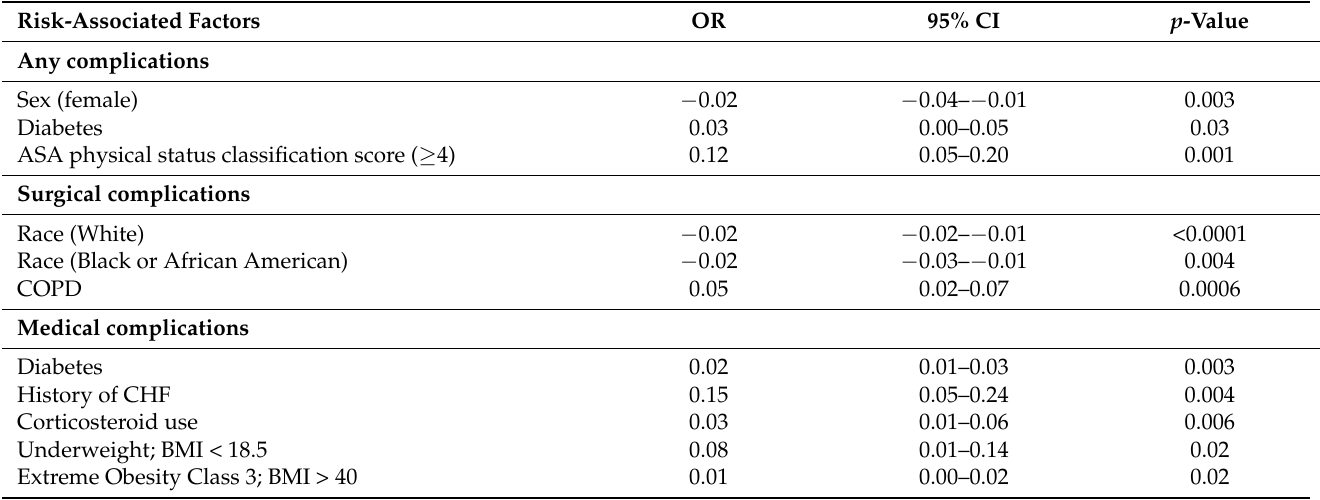
Table 7. Multivariable assessment of any, surgical, and medical complication occurrences for all patients undergoing head and neck OSA surgery.